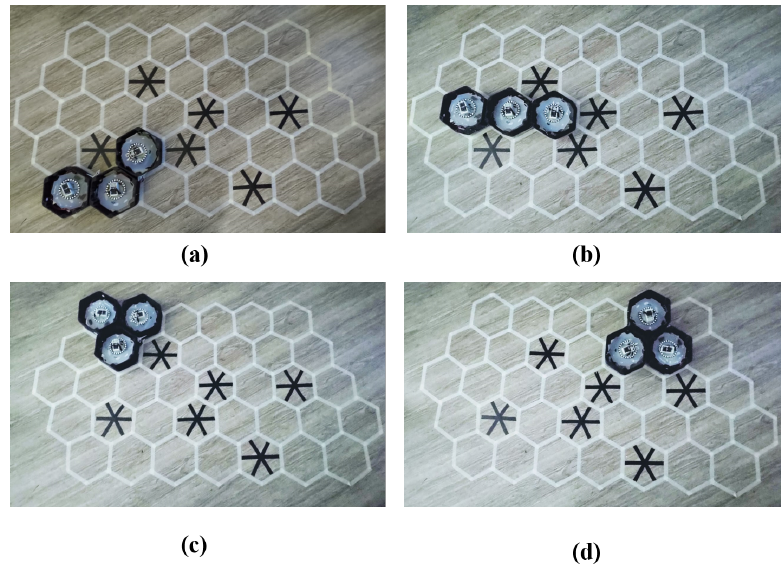
Figure 18. Real tested workspace with obstacles as crossed cells as in the simulated workspace in Figure 14d: ( a ) robot at waypoint 1; ( b ) robot at waypoint 5; ( c ) robot at waypoint 7; and ( d ) robot at waypoint